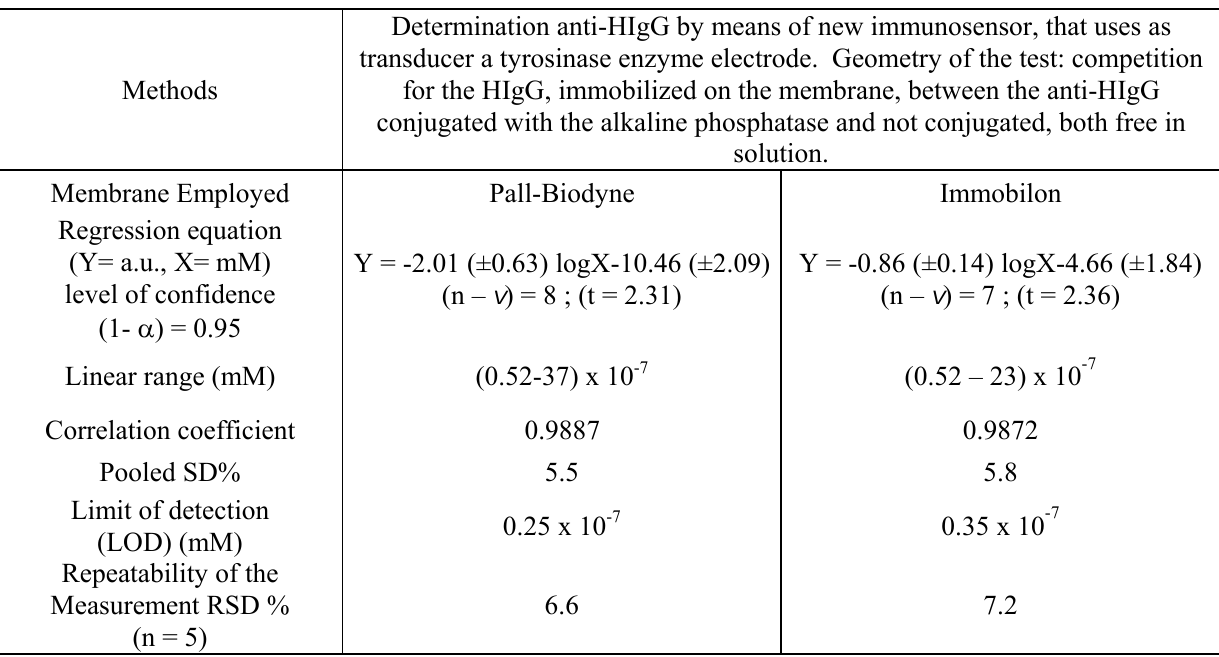
Figure 6. (a) Behaviour of the new immunosensor response as a function of growing HIgG concentration, using Pall-Biodyne or Immobilon membrane; (b) corresponding calibration curve and confidence interval for the HIgG determination, obtained using a semilogarithmic scale.